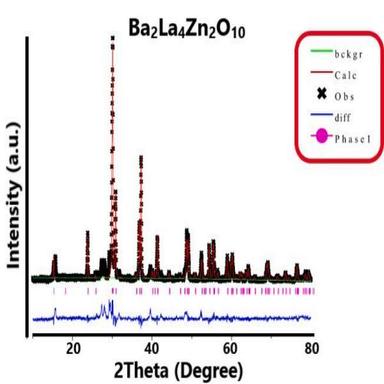
Rietveld refinement results performed over host matrix Ba2La4Zn2O10 yielding the refined parameters of wRP (Goodness of fit) = 10.62 %, RP (Residual of least squares) = 9.39 % and χ2 = 2.187.